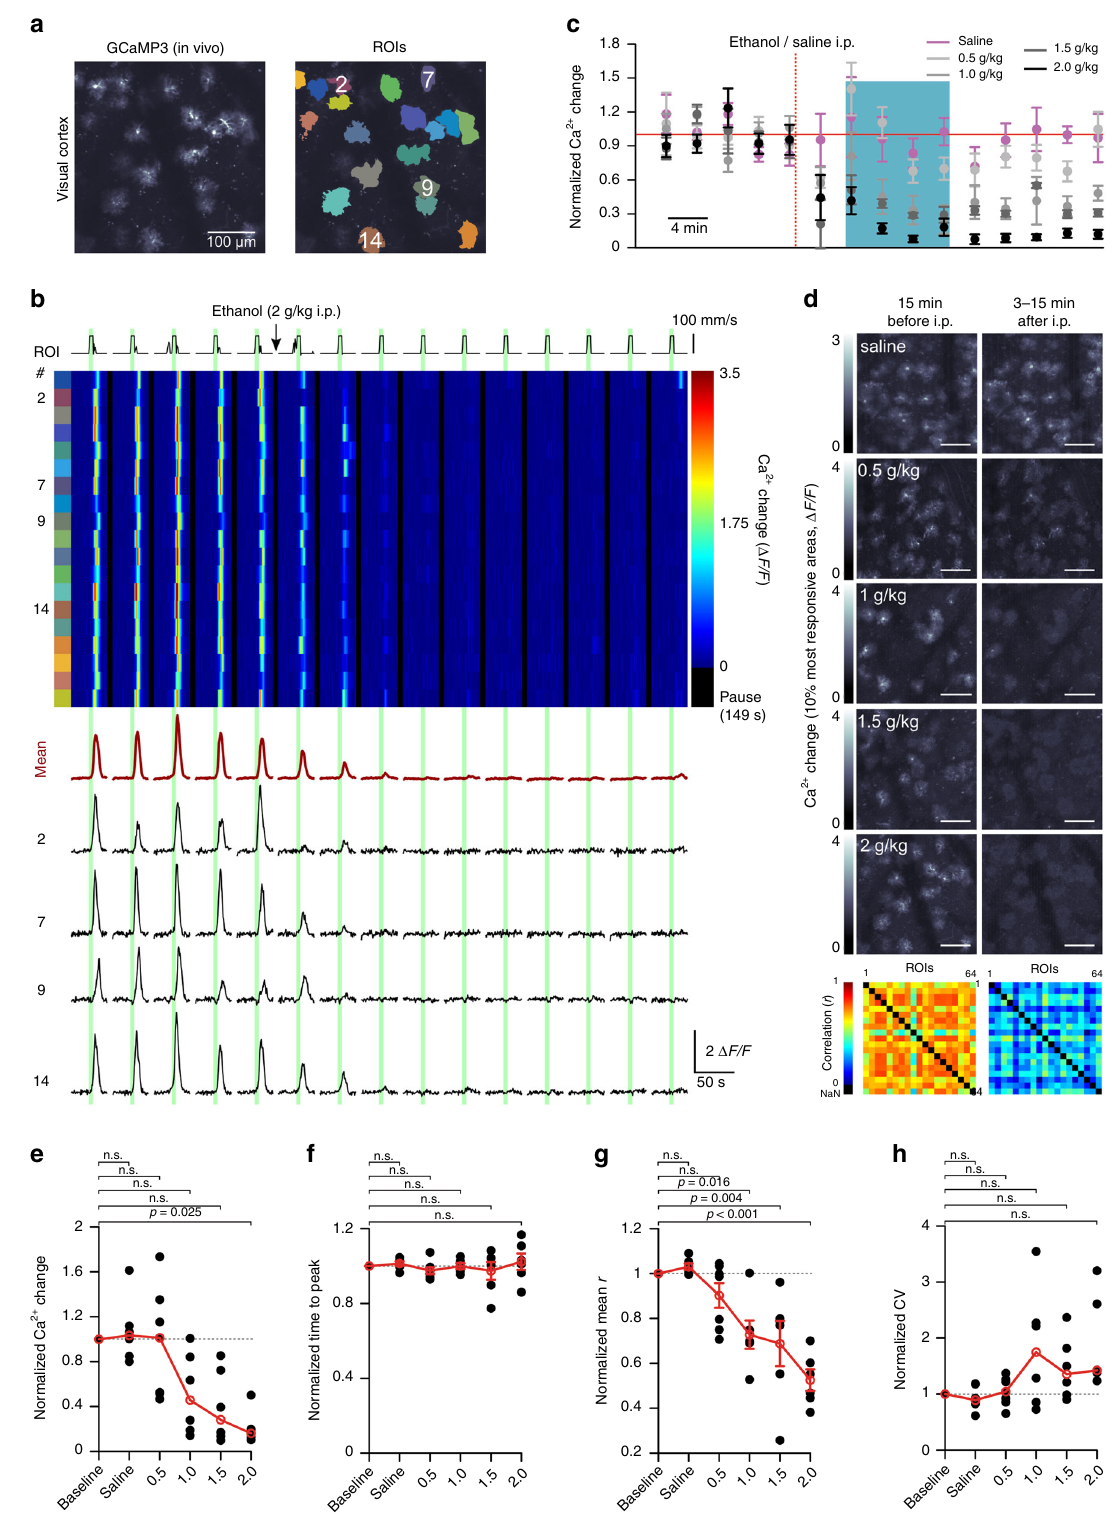
(Fig. 10b, c and Supplementary Movies 3 and 4), suggesting that BG activation is not required for accurate motor coordination. Moreover, restoring BG activation by co-injecting MK912 with ethanol did not improve motor coordination during ethanol exposure (Fig. 10d), and neither baseline motor coordination nor its sensitivity to ethanol were affected by ablating NE-dependent BG activation (Fig.